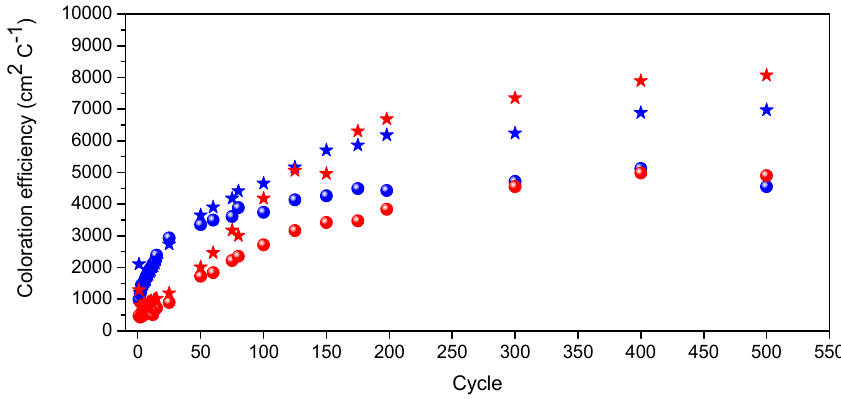
Figure 7. Coloration efficiency for the de-inserted (spheres) and inserted (stars) charges for ECD@LiTrif-ErTrif 3 (blue symbols) and ECD@LiTrif-[Er(tta) 3 (H 2 O) 2 ] (red symbols).